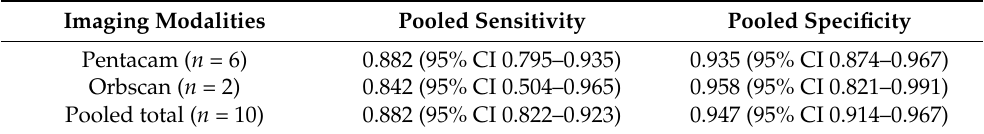
Table 3. Diagnostic performance of machine learning on detection early KC using different imag- ing